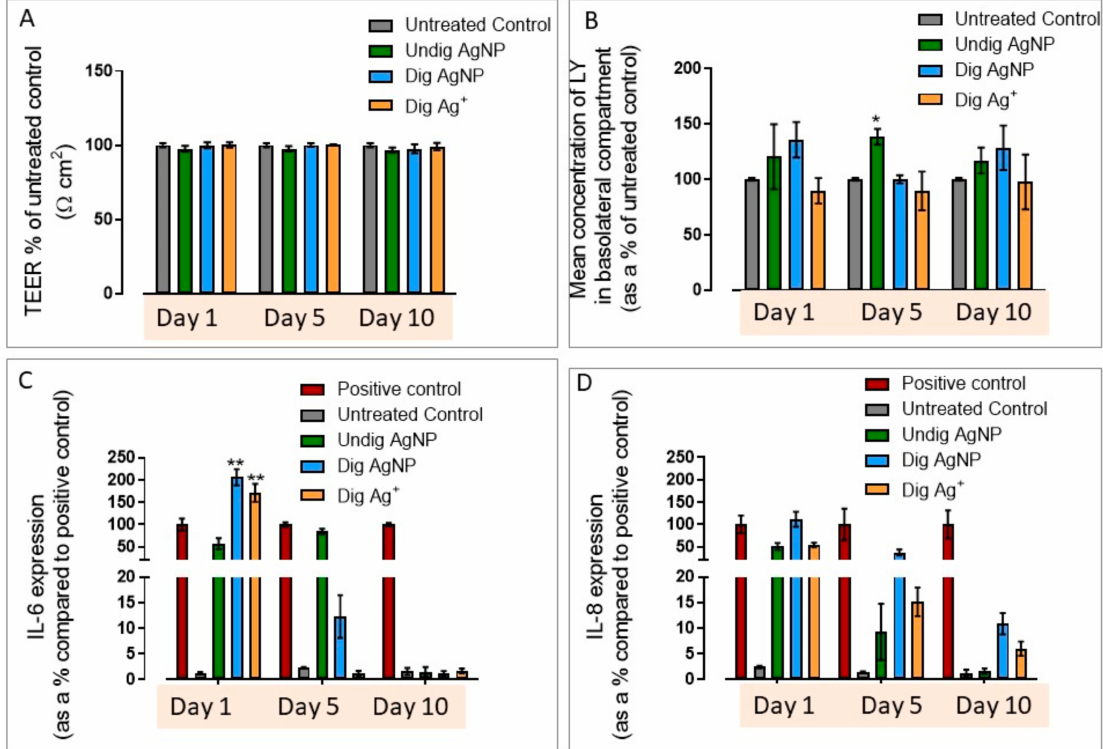
Figure 7. ( A ) Trans-epithelial electrical resistance (TEER) measurements of cell monolayers and ( B ) Lucifer yellow (LY) permeability assay results for undig AgNPs (green), dig AgNPs (blue) and dig Ag + (orange) as compared with untreated control cell layers (grey) on days 1, 5 and 10. Statistical significance is represented respect to untreated control (* p < 0.05). ( C ) interleukin-6 (IL-6) and ( D ) IL-8 release in the apical medium following chronic exposure to the three silver species on days 1, 5 and 9 presented as a percentage compared to the response generated by the positive control (composed of 25 ng/mL IL-1 β , 1 µ g/mL lipopolysaccharide (LPS), 50 ng/mL tumor necrosis factor apha (TNF α ) and 50 ng/mL interferon gamma (IFN- γ )). Statistical significance is represented with respect to positive control (** p <